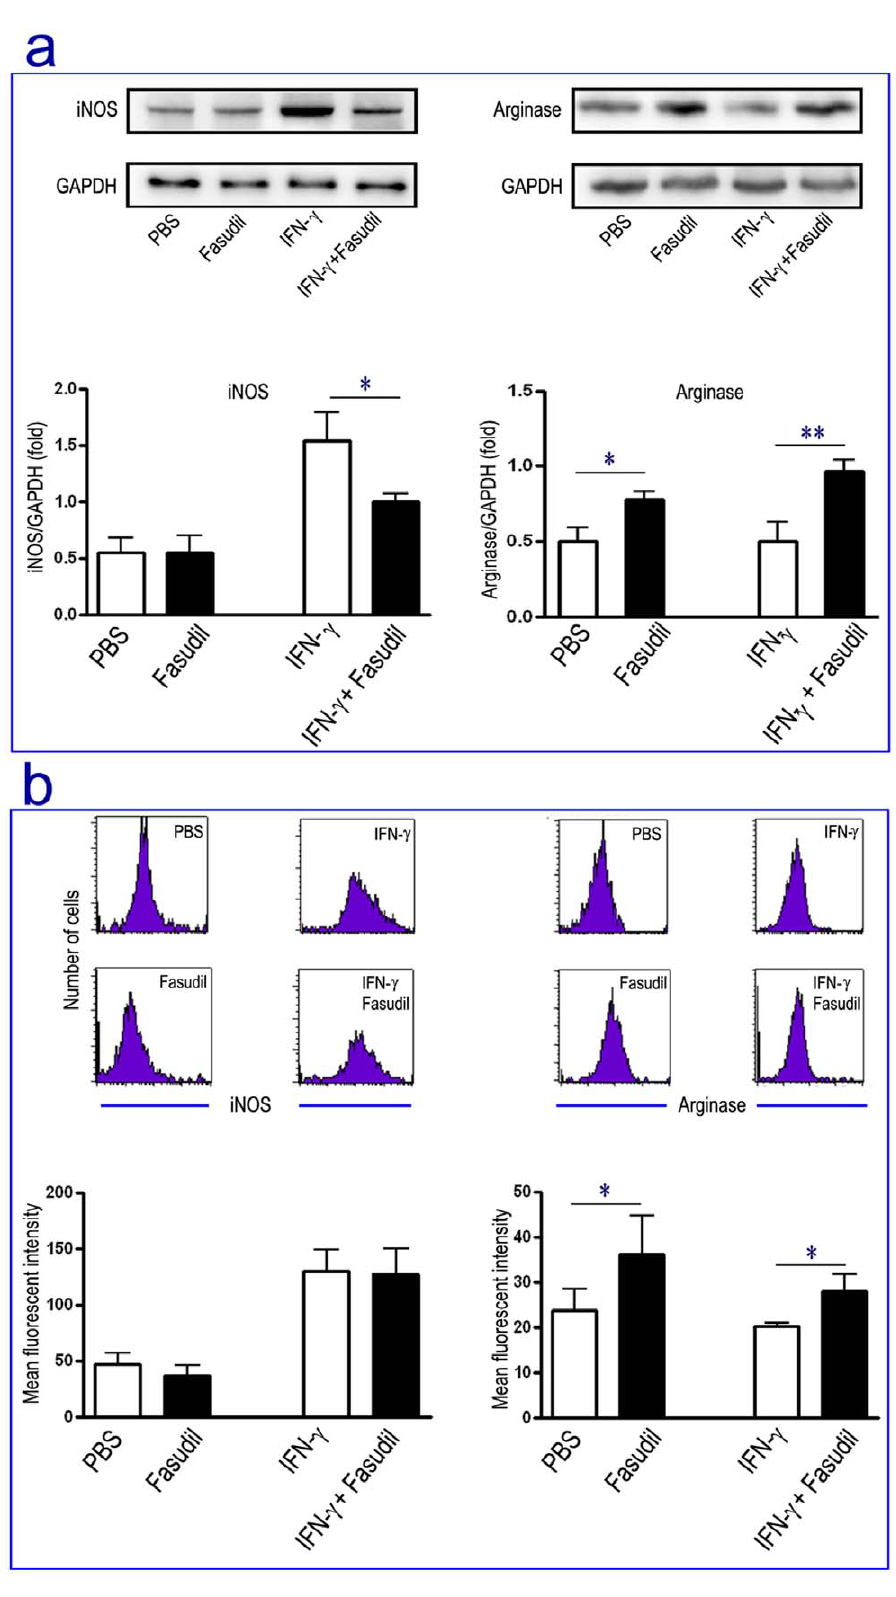
Figure 7. Fasudil directly shifts M1 to M2 phenotype in macrophages. Macrophages from healthy mice were purified and stimulated with IFN- c . Fasudil was added for 12 h immediately after IFN- c treatment. The levels of iNOS and Arg-1 were measured by Western blot (a) and flow cytometry (b). The results were analyzed from three independent experiments. * p , 0.05, ** p , 0.01.